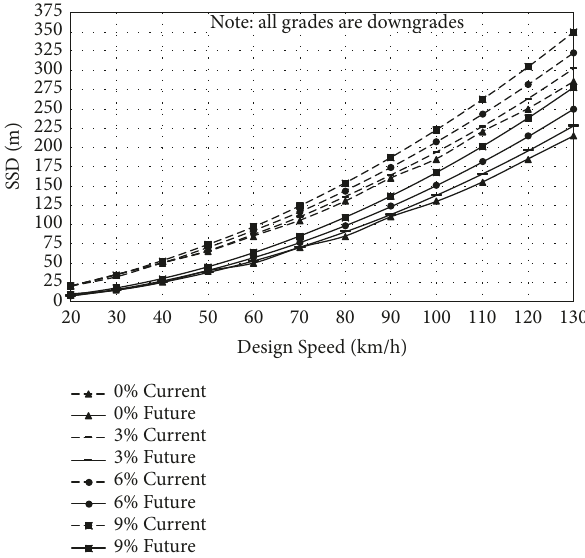
Figure 1: SSD values for current and future design standards for selected vertical